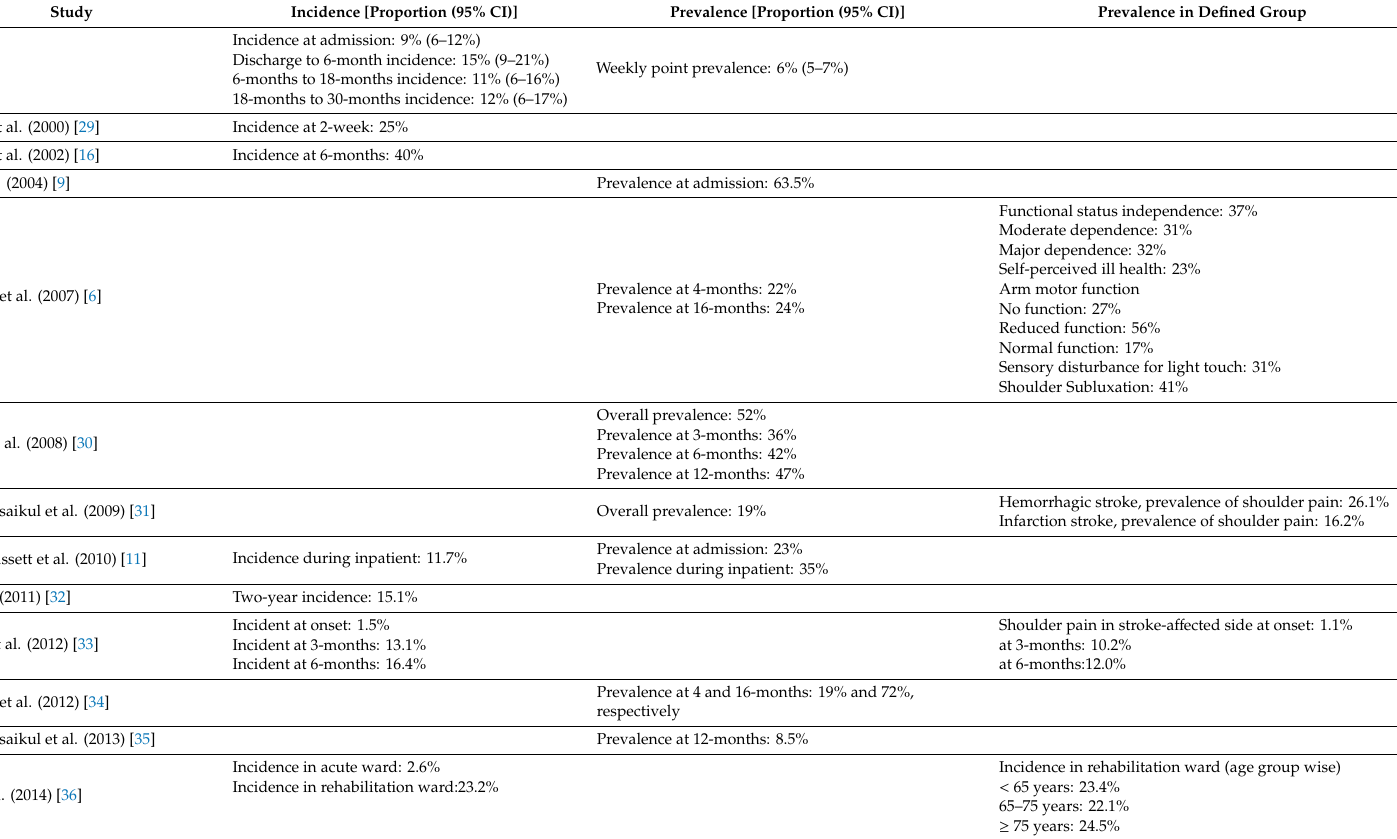
Table 4. Incidence and prevalence of shoulder pain after stroke in the included